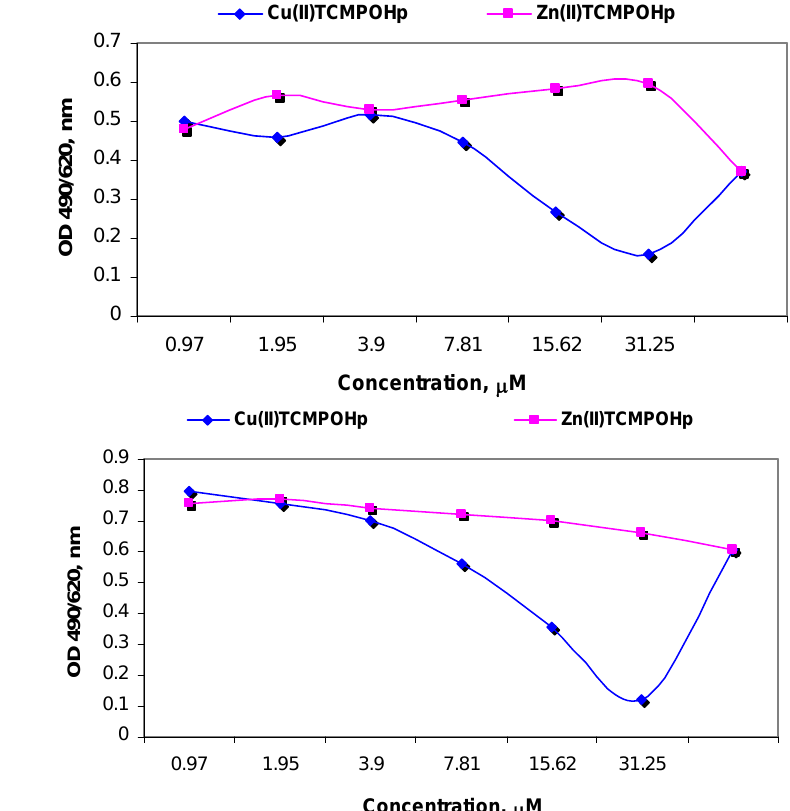
Figure 4. The proliferation of HT29 cells incubated 2 h ( a ) and 24 h ( b )